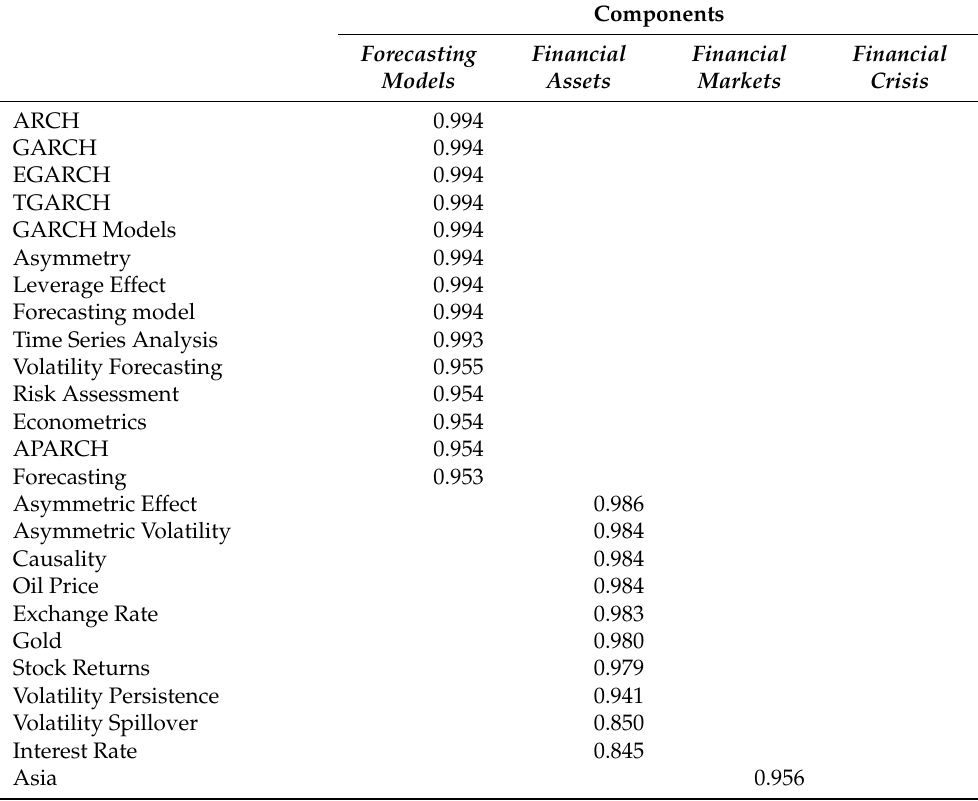
Table 7. Rotated Component Matrix and factor loadings of thematic